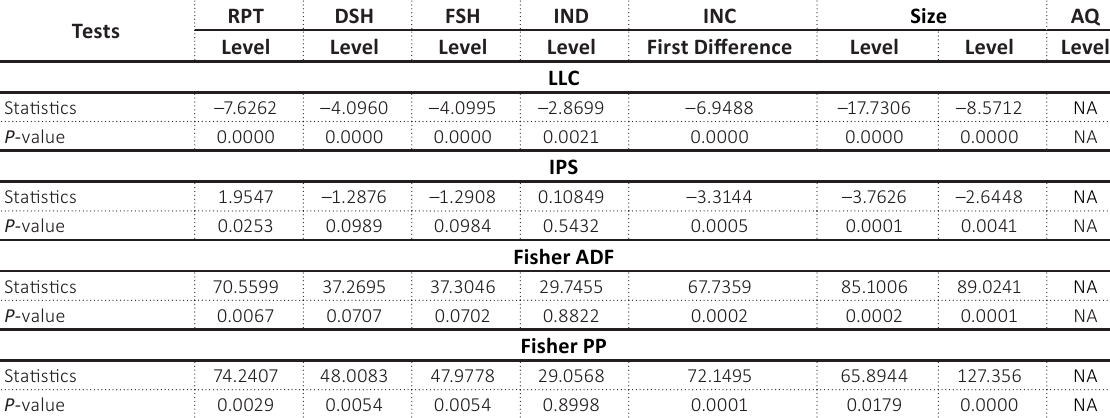
Table 4. Panel unit root test of the variables